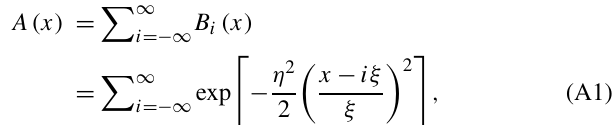
Figure A1. Relationship between the volume size distribution and η . The black line is the volume size distribution, which is computed by the integration of 20-modal lognormal distribution functions (red lines). Blue circles are the peak volume of the lognormal size dis- tribution.